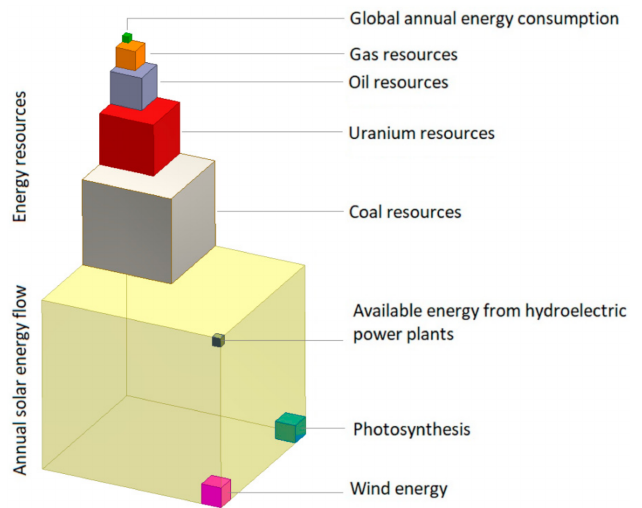
Figure 1. Global annual energy consumption in relation to resources